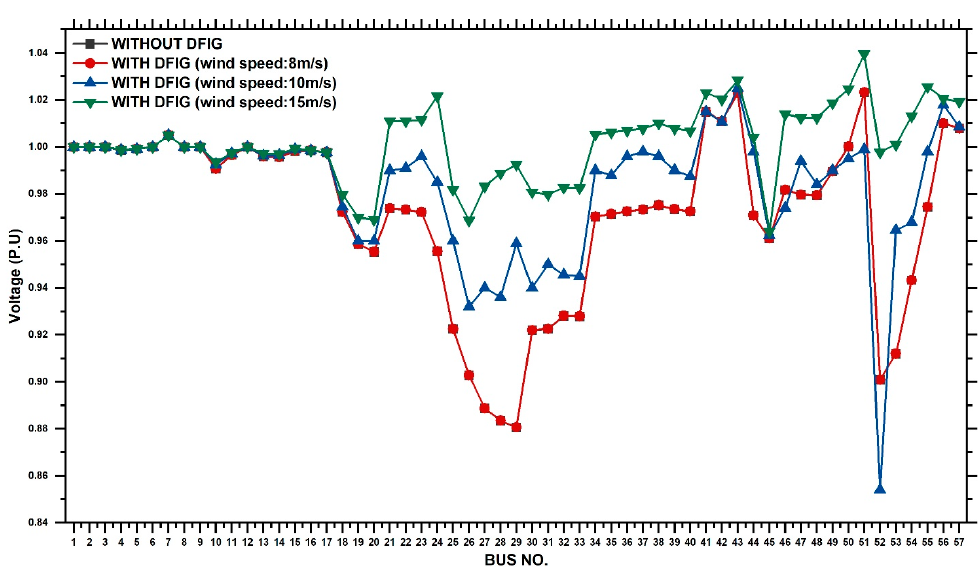
Figure A1. Comparison of DFIG output voltage with different wind speeds.